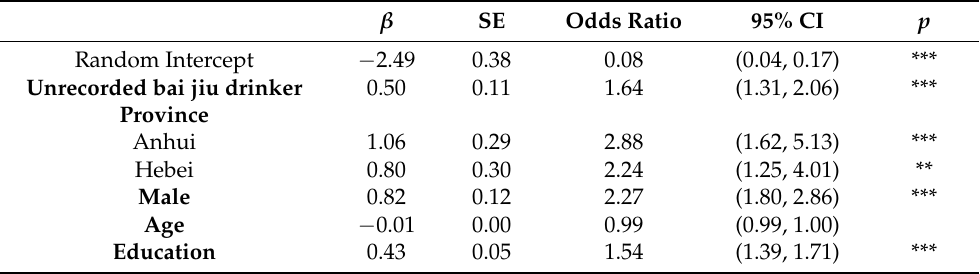
Table 8. Two-level logistic regression model of the effect of unrecorded bai jiu drinker and province on being pushed to drink.